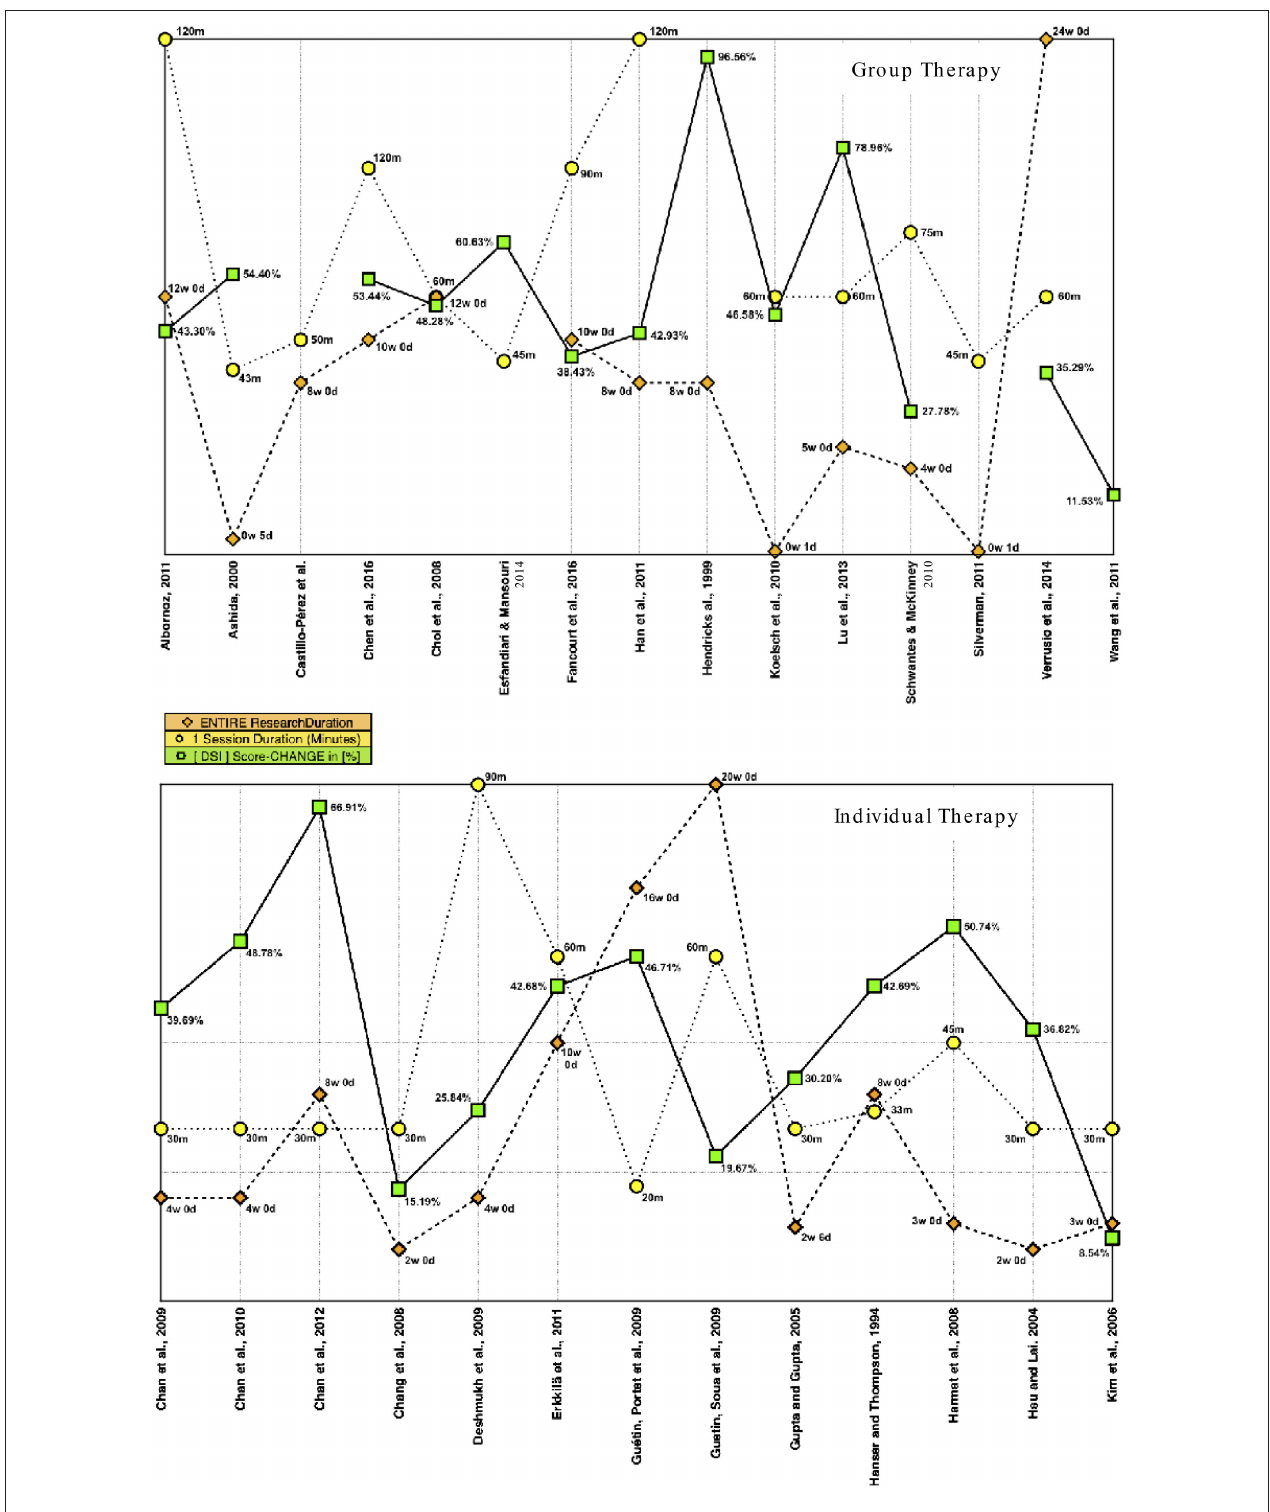
FIGURE 3 | Session- and research duration–vs.–[DSI] results in dependence of treatment setting.